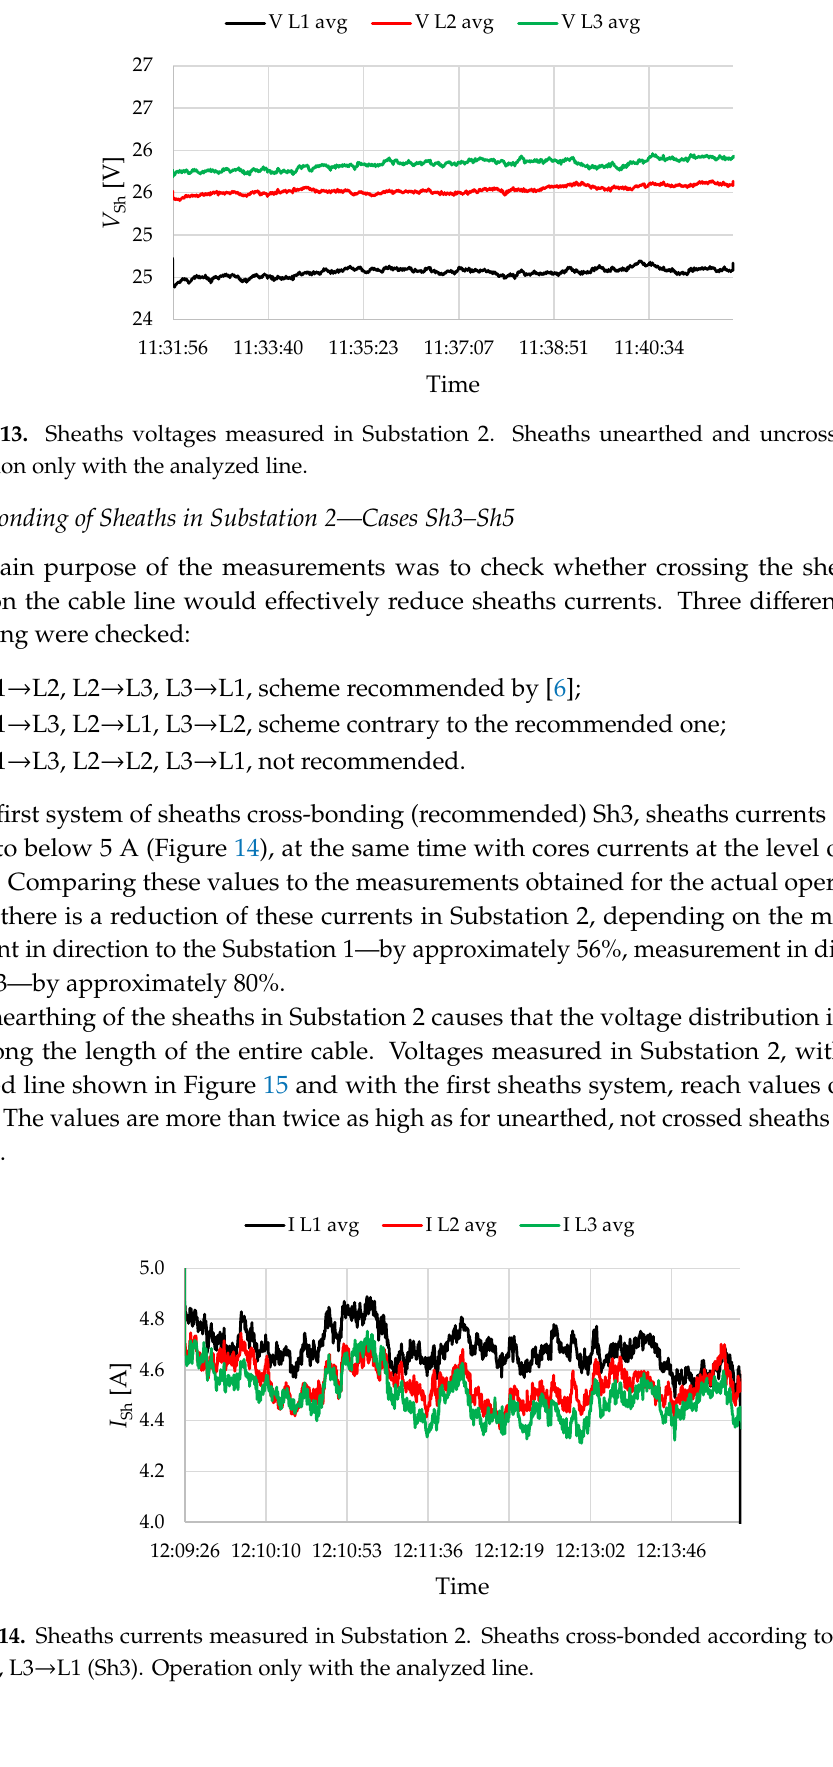
Operation only with the analyzed line.